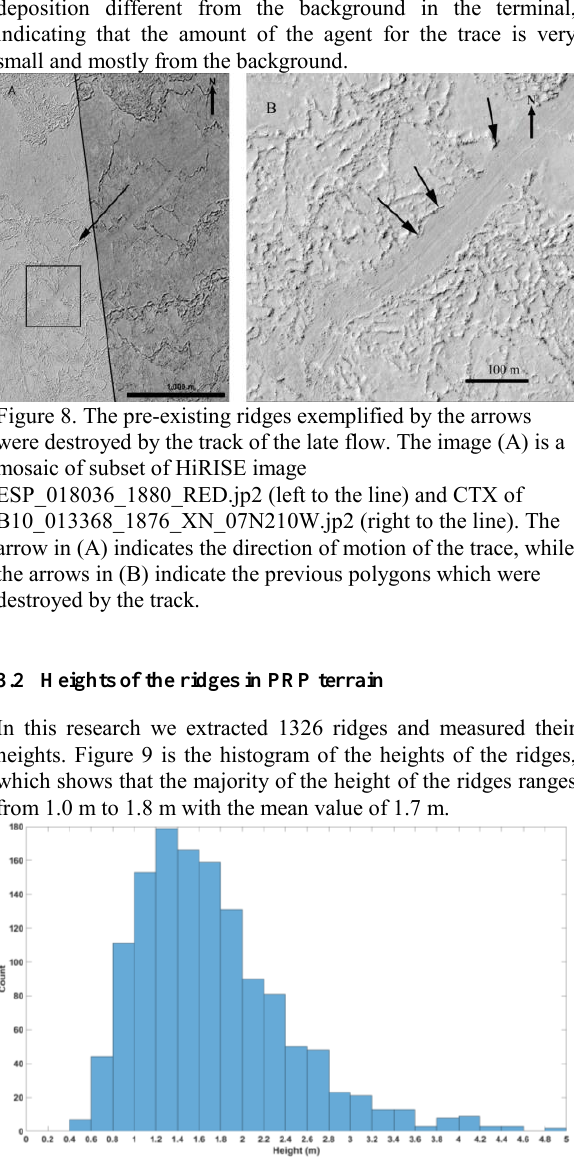
Figure 9. Histogram of measured ridge